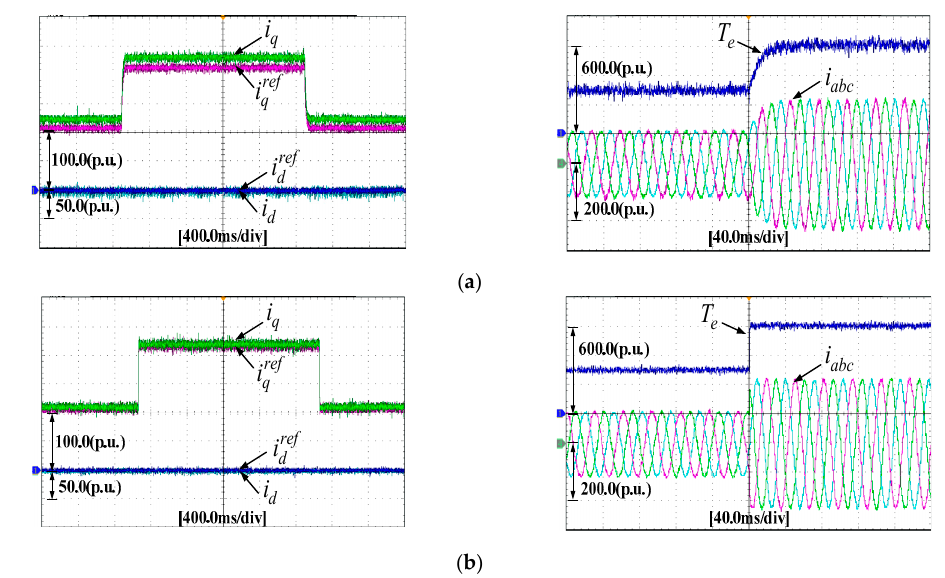
Figure 14. Experimental comparison of the two controllers against inductance parameter perturbation (